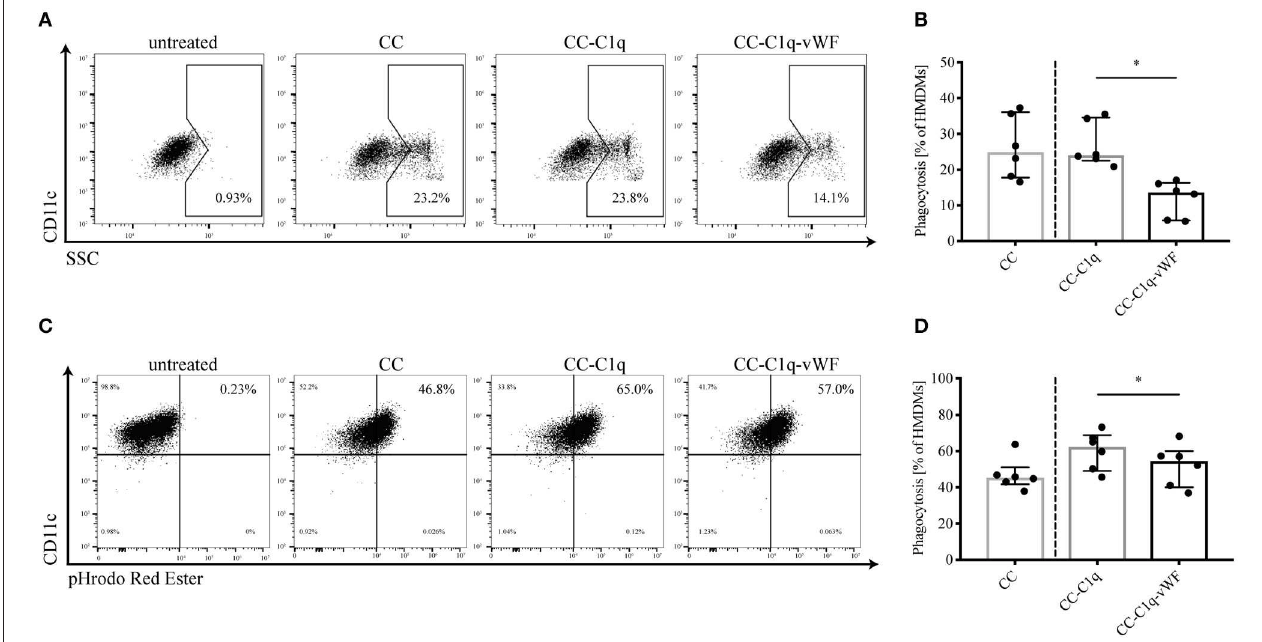
FIGURE 3 | Phagocytosis of CC-C1q-vWF complexes by HMDMs is hampered. (A,B) HMDMs were kept untreated or treated with CC, CC-C1q or CC-C1q-vWF complexes for 18h and analyzed by flow cytometry for the degree of phagocytosis of CC complexes. Phagocytosis was determined by the percentage of CD11c + cells with a shift into the SSC high gate. (A) Flow cytometry dot plots show one out of six independent experiments. (B) Quantification of phagocytosis for pooled data is shown. (C,D) HMDMs were treated with CC, CC-C1q or CC-C1q-vWF pHrodo-dyed complexes for 30min and analyzed by flow cytometry for the degree of phagocytosis of CC complexes. Phagocytosis was determined by the percentage of CD11c + cells with a shift into pHrodo Red Ester + gate. (C) Flow cytometry dot plots show one out of six independent experiments. (D) Quantification of phagocytosis for pooled data is shown. Columns denote median while error bars indicate interquartile range. Data points represent independent experiments analyzing six different healthy donors used to obtain HMDMs (Wilcoxon matched pairs signed rank test, * p <